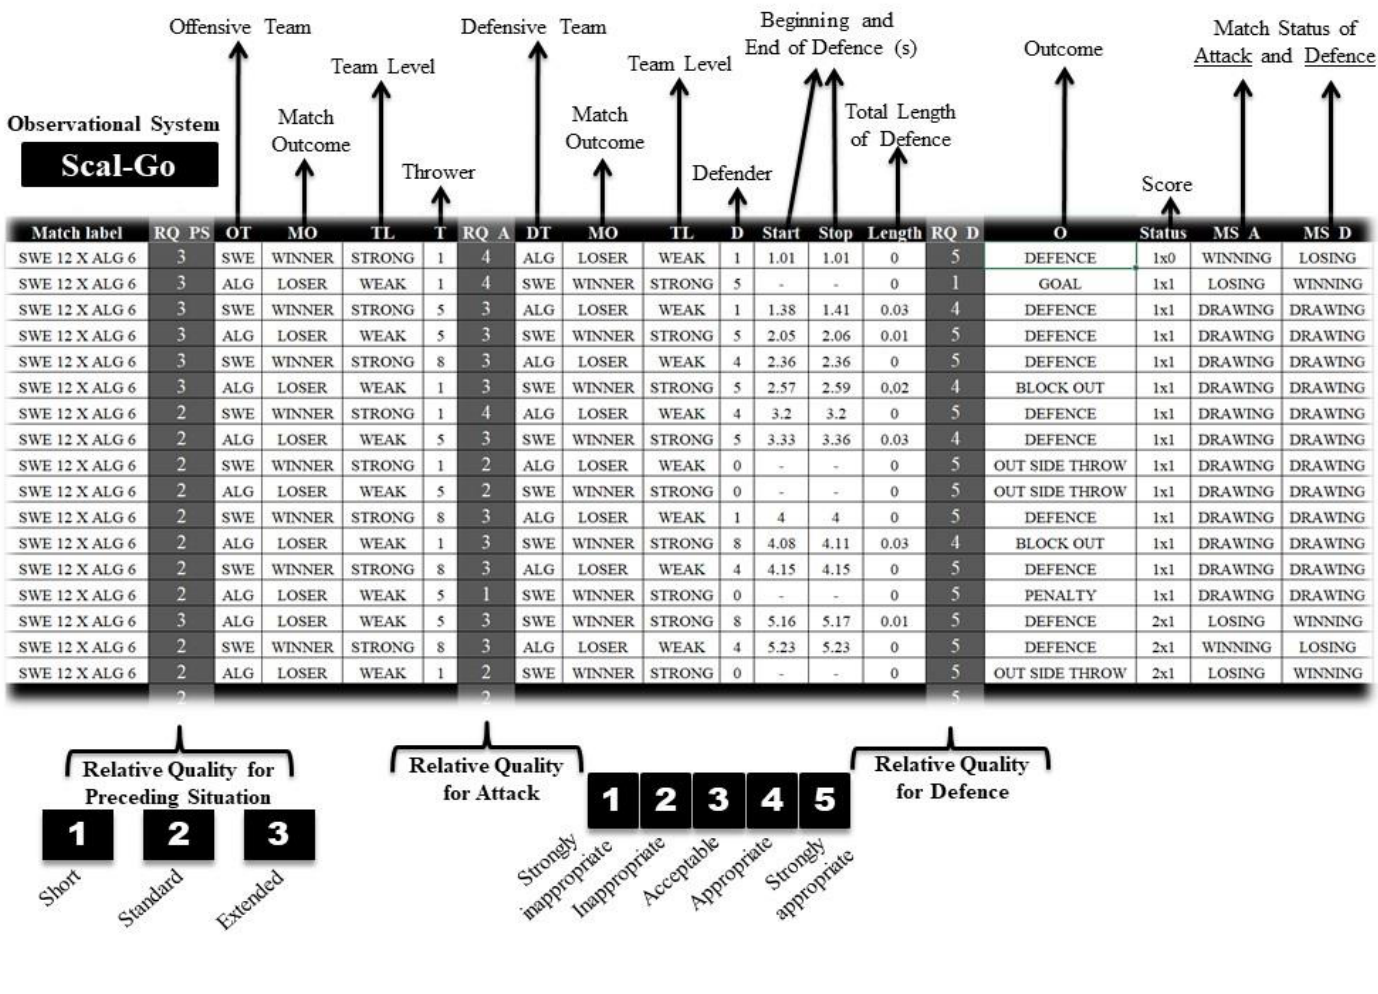
Figure 1 . Observational system for goalball match qualification: Scal-Go.